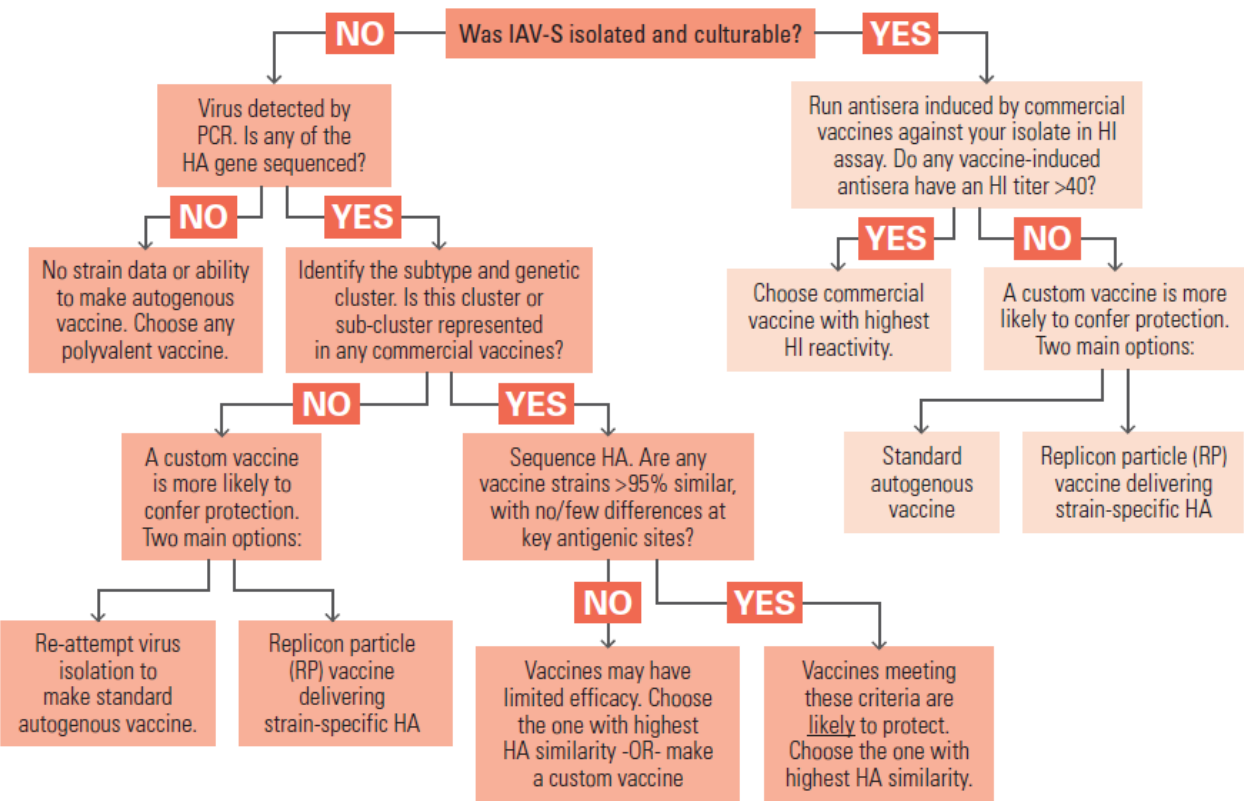
Figure 4. Decision tree for selection of IAV-S vaccine strategy to control a specific herd isolate. Due to the diversity and rapid evolution of IAV-S, there are currently no one-size-fits-all vaccine options. Since commercial polyvalent vaccines from different manufacturers contain different strains, diagnostic data (HA sequence and/or serological comparisons) may identify one vaccine that matches a specific field strain better than others. In some cases, data may indicate that commercial polyvalent vaccines offer no close matches to the field strain, suggesting a greater advantage for custom